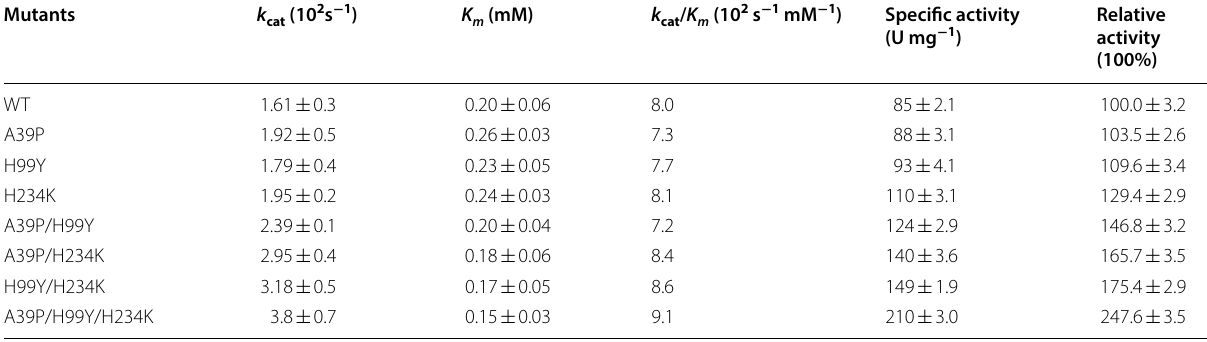
Table 1 Kinetic parameters of UDH from wt and mutants toward substrate glucuronic acid